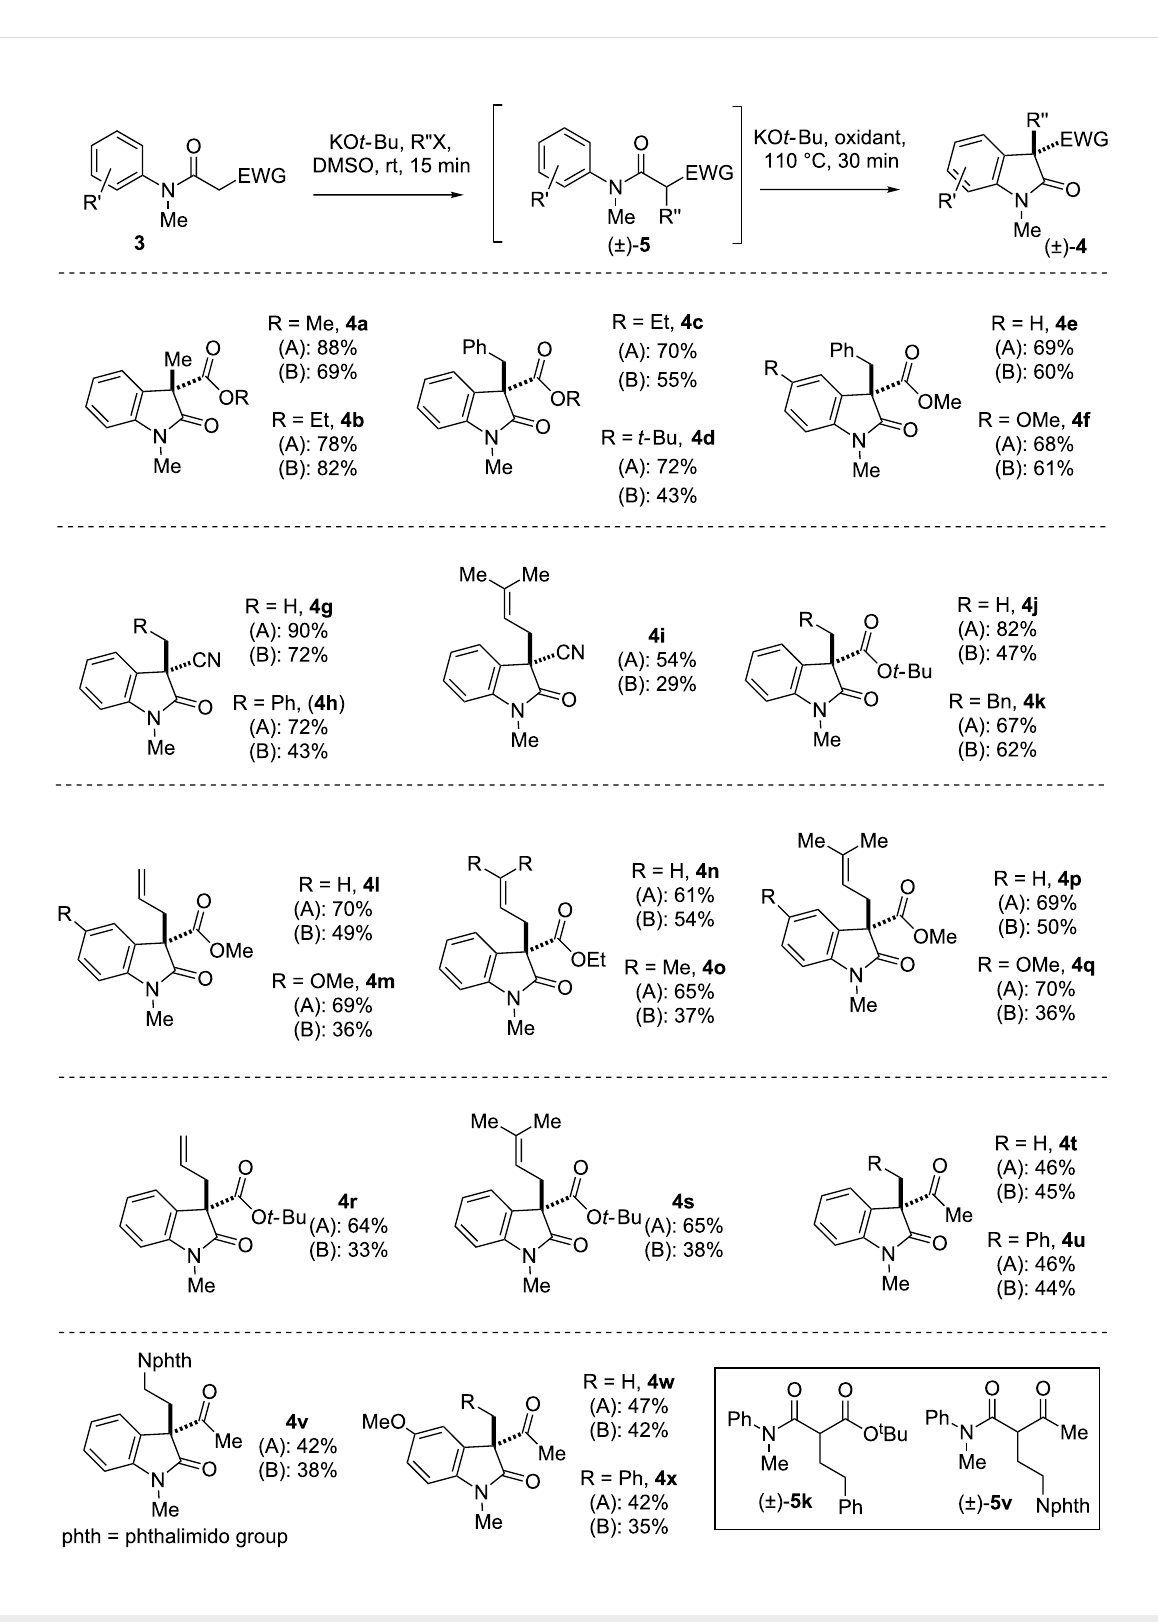
Figure 1: Substrates scope of one-pot ‘transition-metal-free’ IDC. The syntheses of compounds 4a – s according to method A have been reproduced from reference [46]. Conditions A: KO t -Bu, iodine; conditions B: KO t- Bu,